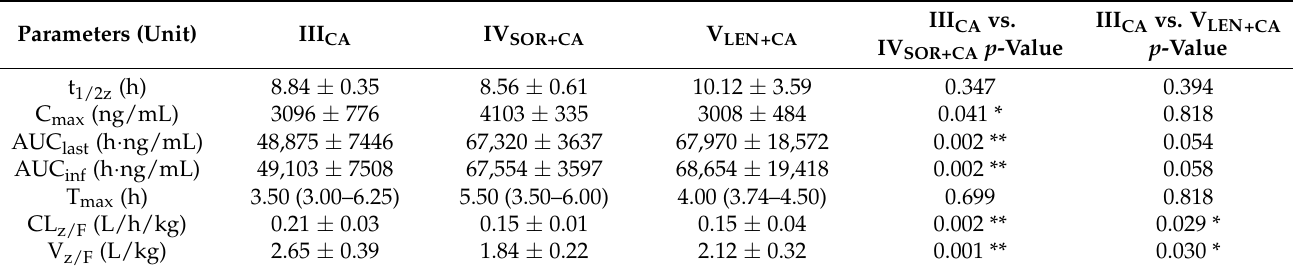
Figure 4. The mean plasma concentration–time curves of canagliflozin after oral administration. Each data point represents the mean ± standard deviation (n = 6). Ⅲ CA , canagliflozin (10 mg/kg); Ⅳ SOR+CA , canagliflozin (10 mg/kg) oral co-administered with sorafenib (100 mg/kg); Ⅴ LEN+CA , canagliflozin (10 mg/kg) oral co-administered with lenvatinib (1.2 mg/kg). Table 5. Pharmacokinetic parameters of canagliflozin in rat plasma after oral administration of single dose canagliflozin (10 mg/kg) and combined with sorafenib (100 mg/kg) and lenvatinib (1.2 mg/kg); n = 6 for each group.